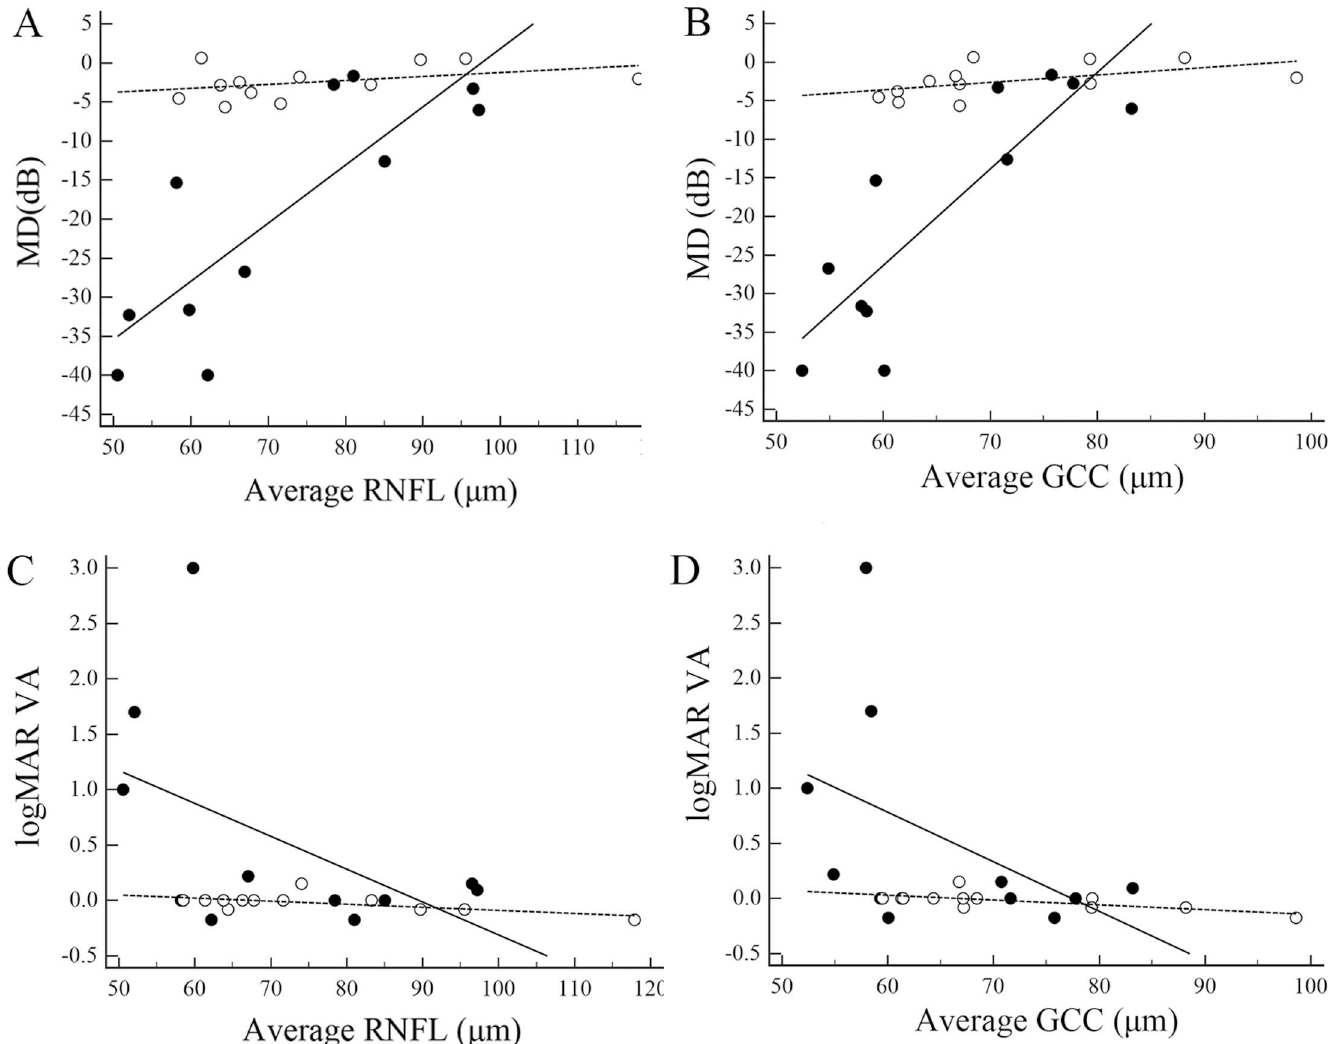
Fig 5. Structure − function relationships in eyes with single-episode optic neuritis. Scatter plots of mean deviation(MD) againstcircumpapillary retinal nerve fiber layer (RNFL) averagethickness (A), MD againstganglioncell complex (GCC) thickness (B), logMAR visual acuity (VA) against circumpapillary RNFL averagethickness (C), and VA againstGCC averagethickness (D). Open circles and dotted lines indicateeyes with aquaporin 4 antibody(AQP4 Ab)-negative optic neuritis, whereasclosed circles and solid lines indicate eyes with antibody-positive optic neuritis. Spearmanrank correlationcoefficients(95% confidenceinterval, P-value) for the antibody-negativeand -positive groupswere 0.39 (-0.24 to 0.79, 0.22) and 0.75 (0.27 to 0.93, 0.008), respectively,betweenMD and averageRNFL thickness (A), 0.58 (0.01 to 0.87, 0.05) and 0.77 (0.32 to 0.94, 0.006), respectively,between MD and averageGCC thickness (B), -0.47 (-0.82 to 0.14, 0.12) and -0.39 (-0.80 to 0.28, 0.24), respectively, betweenlogMAR VA and averageRNFL thickness (C), and -0.65 (-0.89 to -0.11, 0.02) and -0.62 (-0.89 to -0.02, 0.04), respectively, betweenlogMAR VA and averageGCC thickness